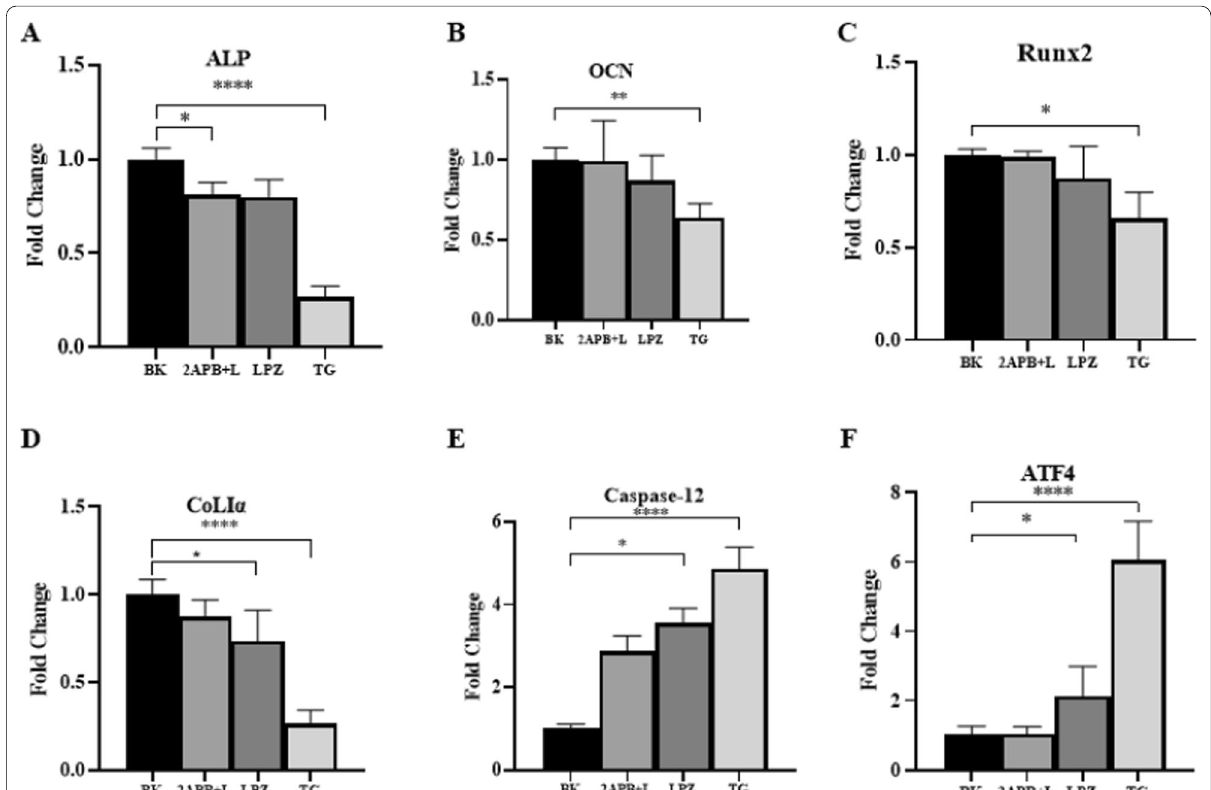
Fig. 10 The mRNA expression of OB functional genes and ER stress and apoptosis pathway-related genes (ALP, OCN, Runx2, COL Ι α, Caspase-12, ATF4). TG was used as a positive control (n =